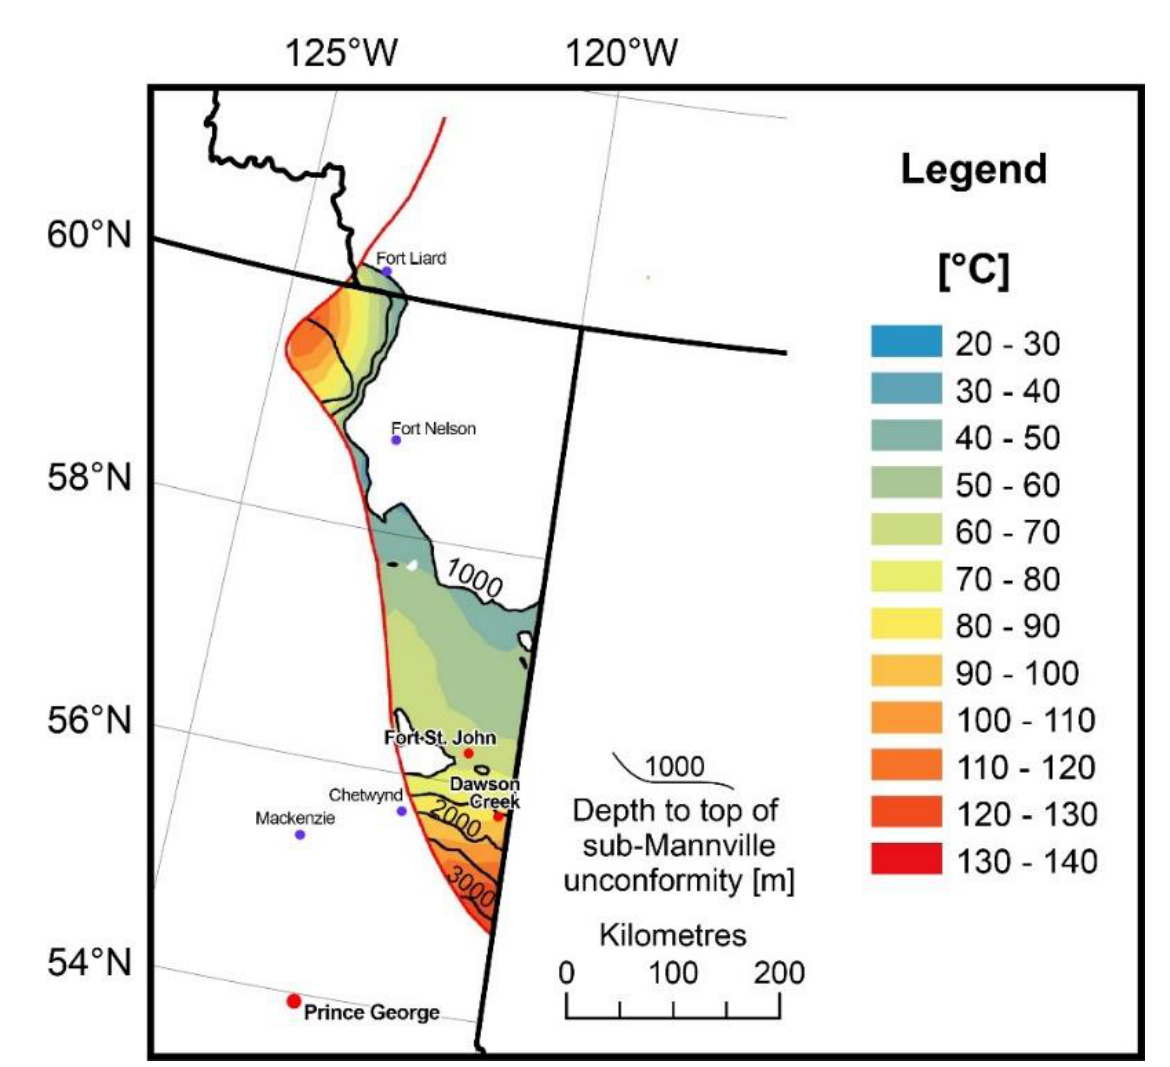
Figure A12. Temperatures top of sub-Mannville Unconformity—NE British Columbia S. NWT WCSB.